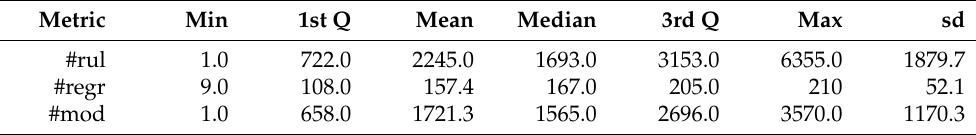
Table 8. Descriptive statistics of the experiment runs for the Crime and Communities dataset.